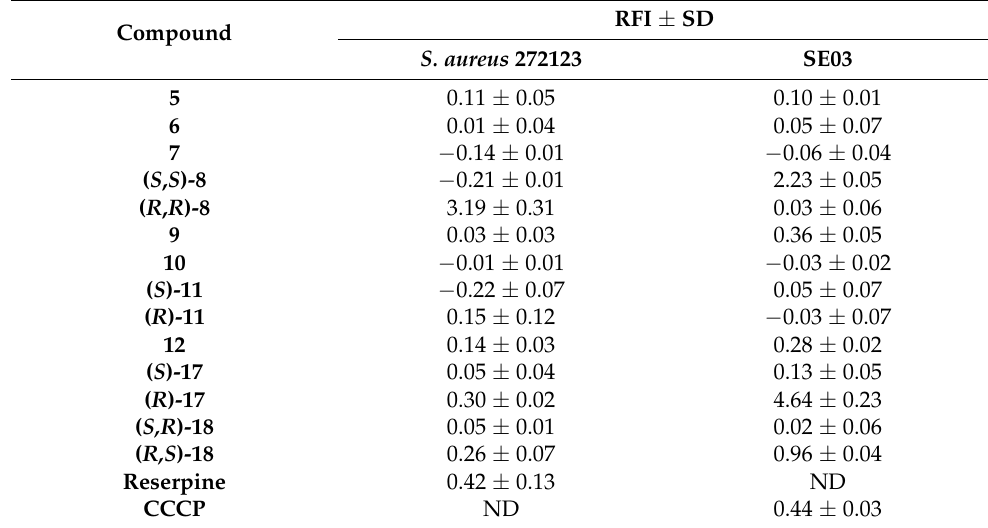
Table 2. Relative fluorescence index (RFI) of the tested chiral xanthones and